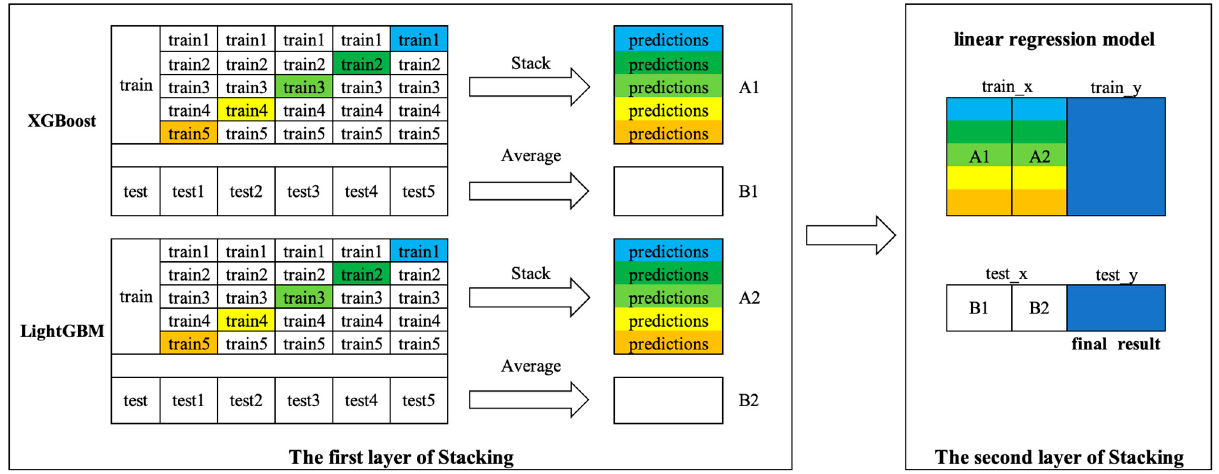
Figure 2. The model structure diagram of the VSFM .